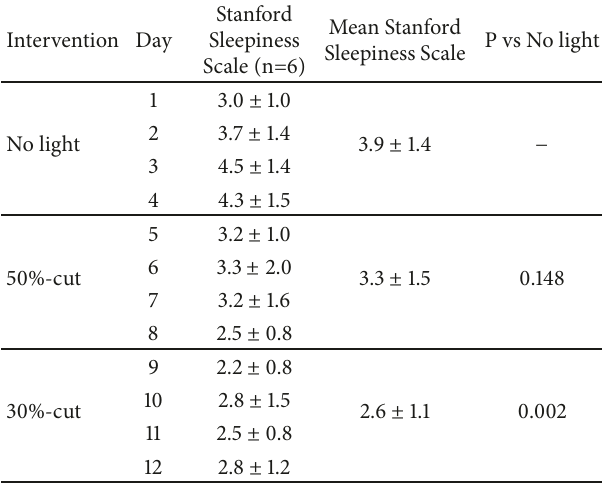
Table 1: Effects of the interventions on the Stanford Sleepiness Scale score. Data are presented as mean ±